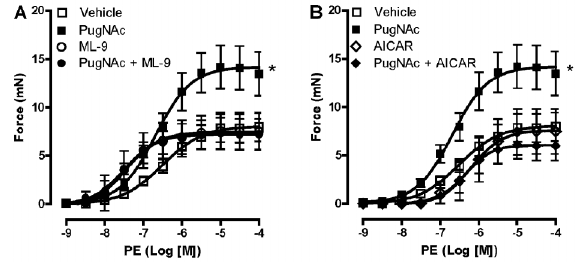
Figure 2. ML-9 and AICAR incubation abolished the differences between the groups. The effect of PugNAc was not observed when vessels were previously incubated with myosin light chain kinase inhibitor (ML-9) ( A ) or with an AMPK activator